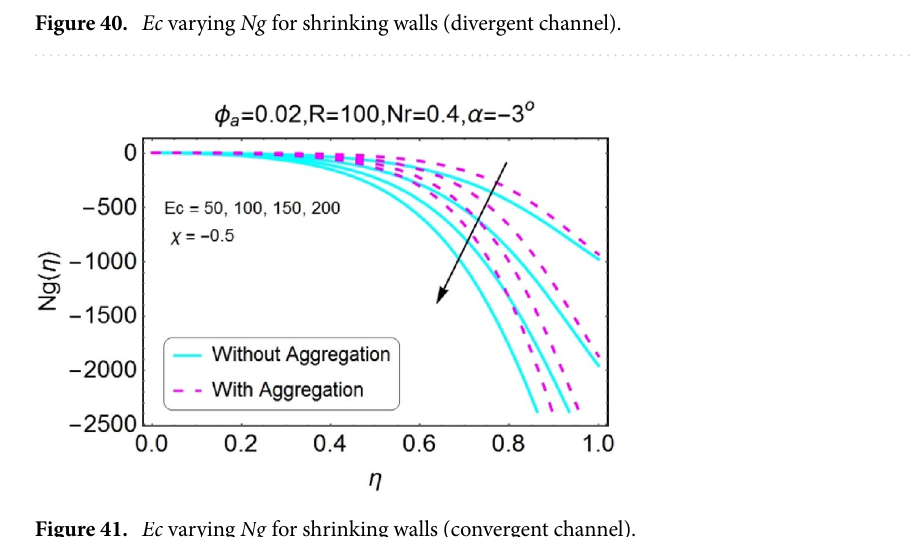
Figure 41. Ec varying Ng for shrinking walls (convergent channel).